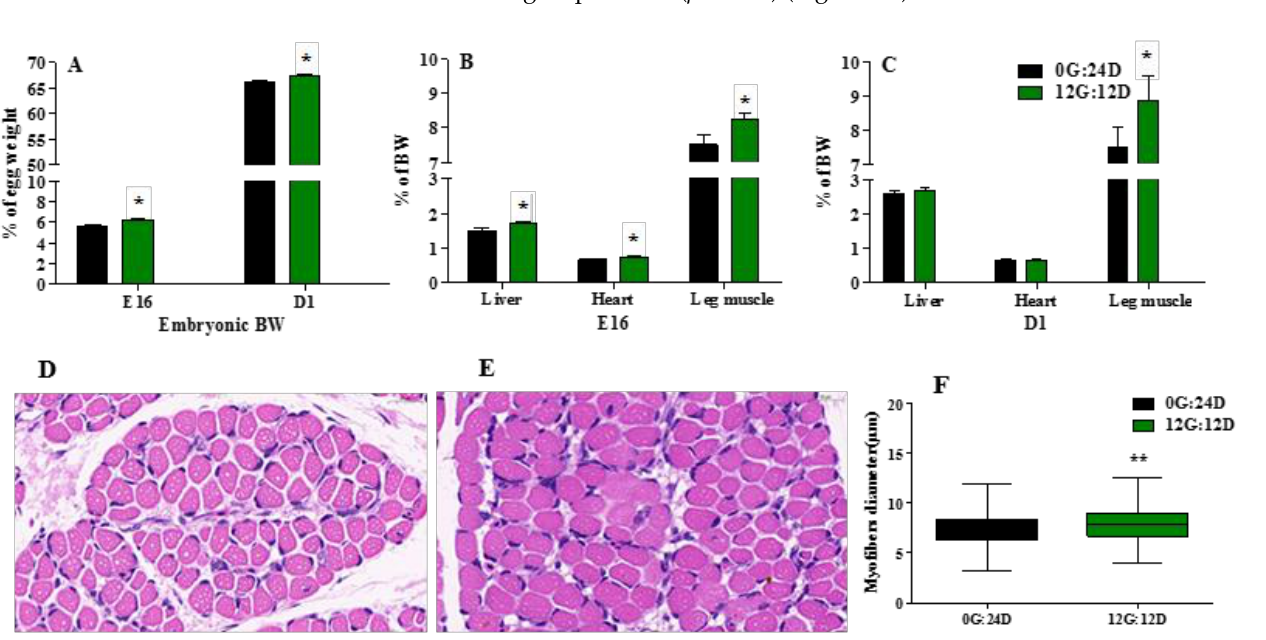
only 7.3 µ m ( p < 0.01, Figure